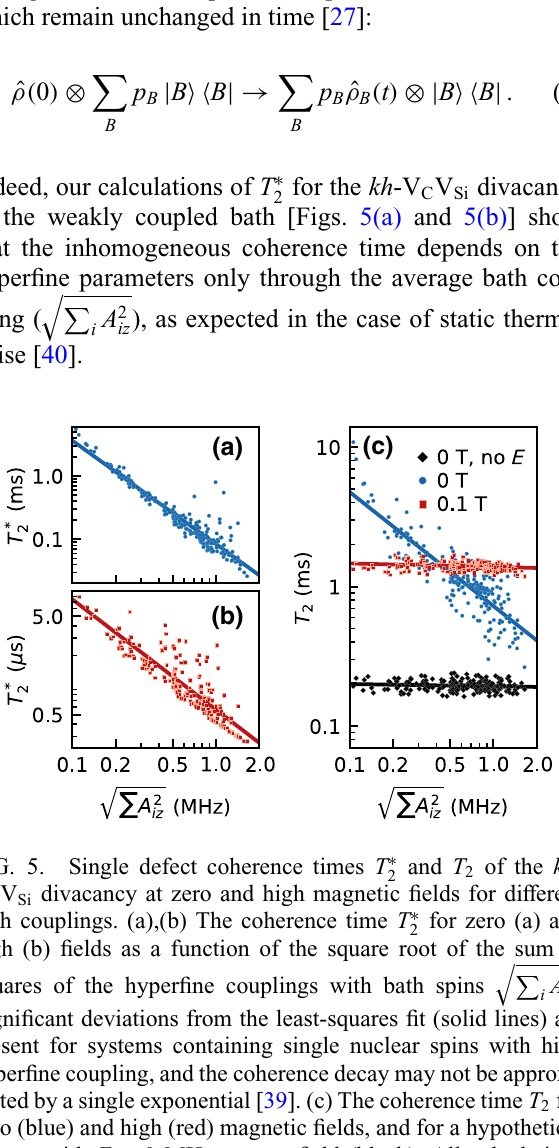
and T 2 of the kh - 2 for zero (a) and 2 (cid:6) (cid:7) . A 2 iz i